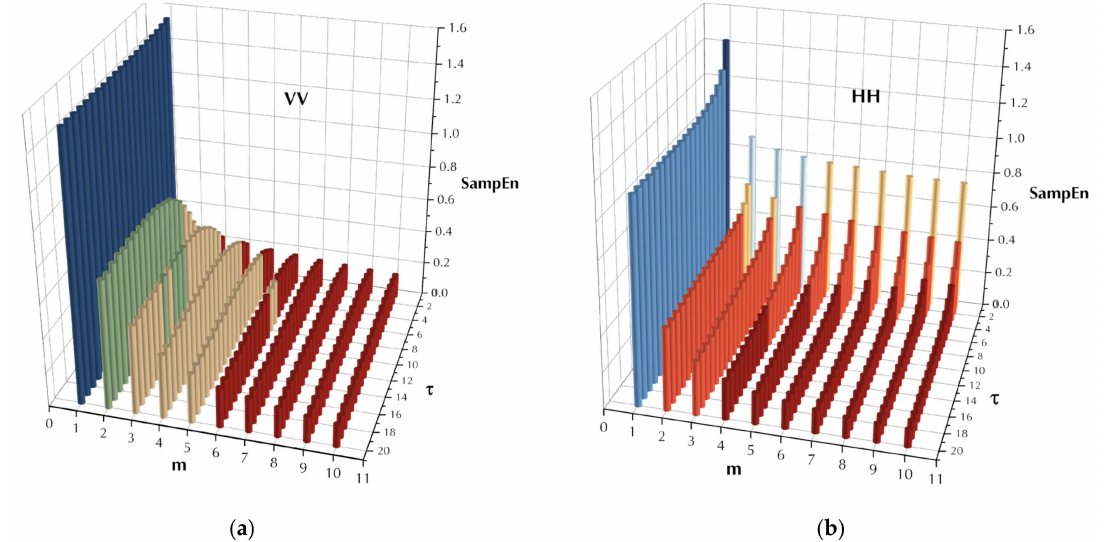
Figure 5. Convergence of SampEn and MSE of pure sea clutter (data set 17, range bin 1): ( a ) VV polarization and ( b ) HH polarization under the parameters τ = 20, r = 0.2 ∗ std { s }